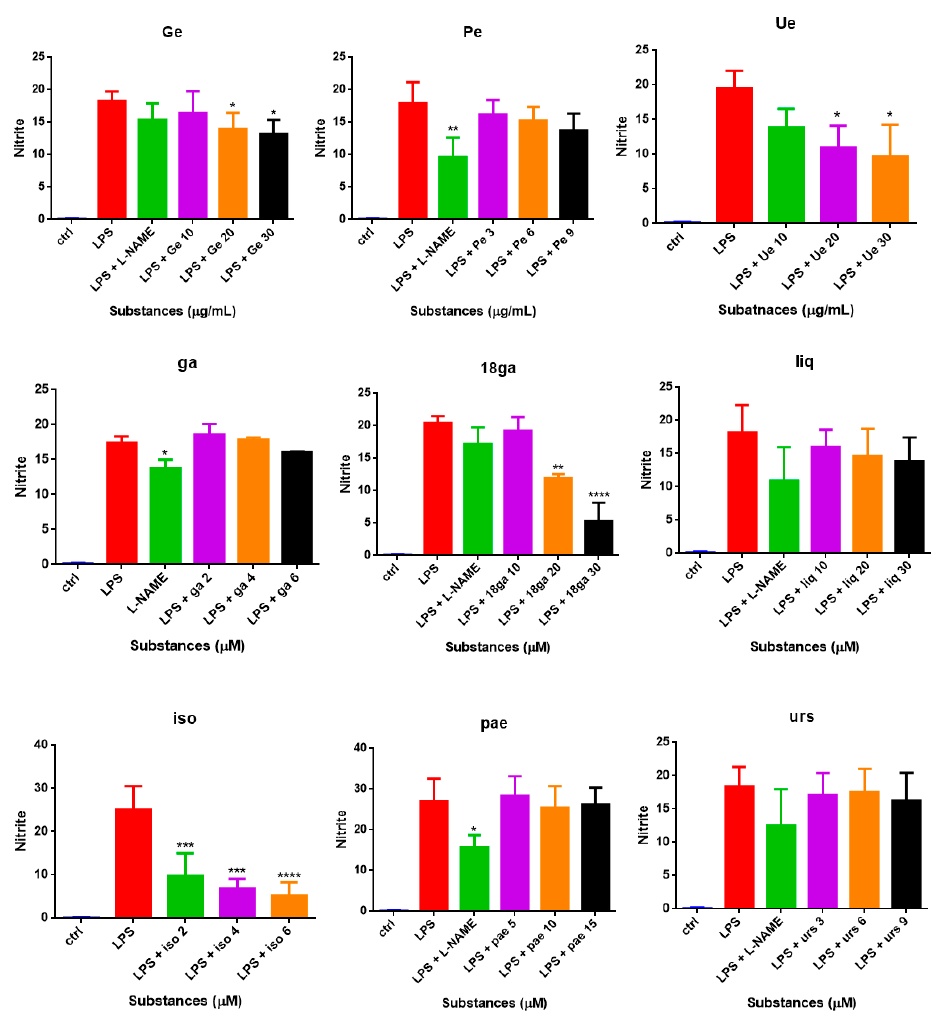
Figure 2. Nitrite levels ( µ M) in the supernatant of RAW 264.7 cells after treatment with LPS and LPS plus PSMs. The non-treated group was defined as the control group. The results are expressed as the mean ± SD from at least three independent experiments. When p < 0.05, the difference was regarded as significant (* p < 0.05; **, p < 0.01; ***, p < 0.001; ****, p < 0.0001).